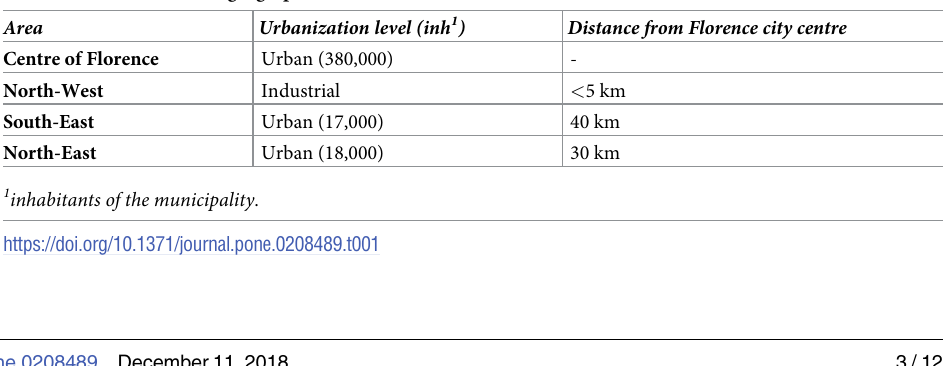
Table 1. Characteristics of geographic